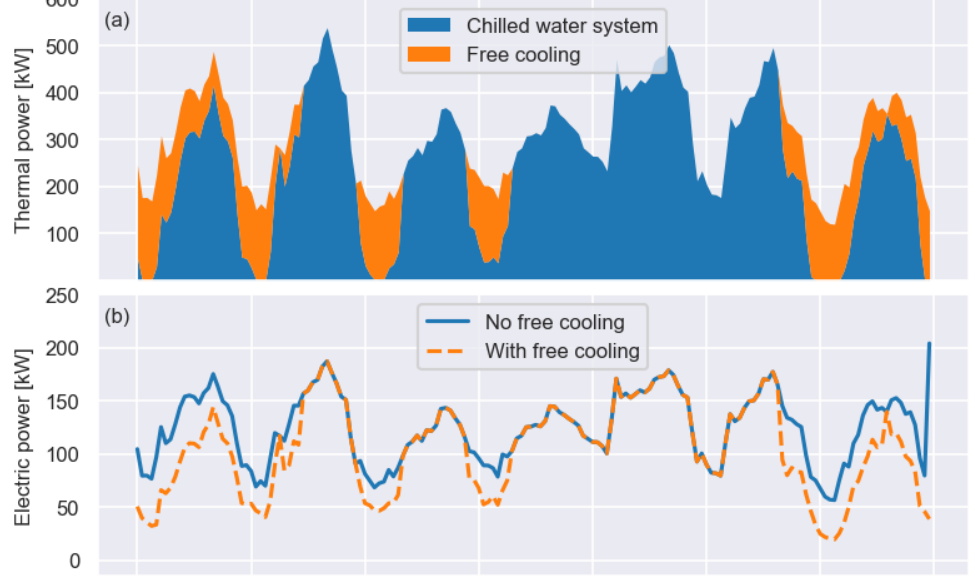
Figure 14. ( a ) Building cooling load satisfied by chilled water system or free cooling and ( b ) electric power with and without free cooling for a one-week period. The electric power is the contribution of the chilled water system power and the increased fan power, as given in Equation (12).